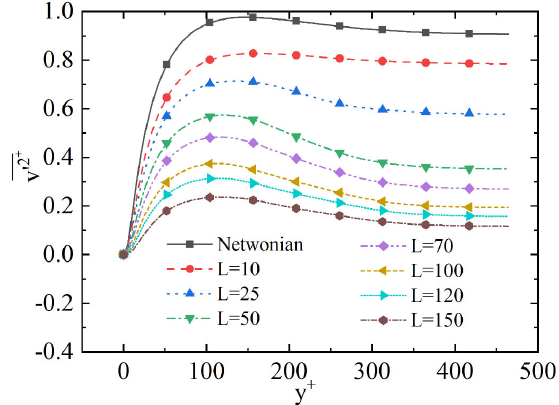
 +  ) of different max ‐ ) of different max ‐ ) of different maxi-